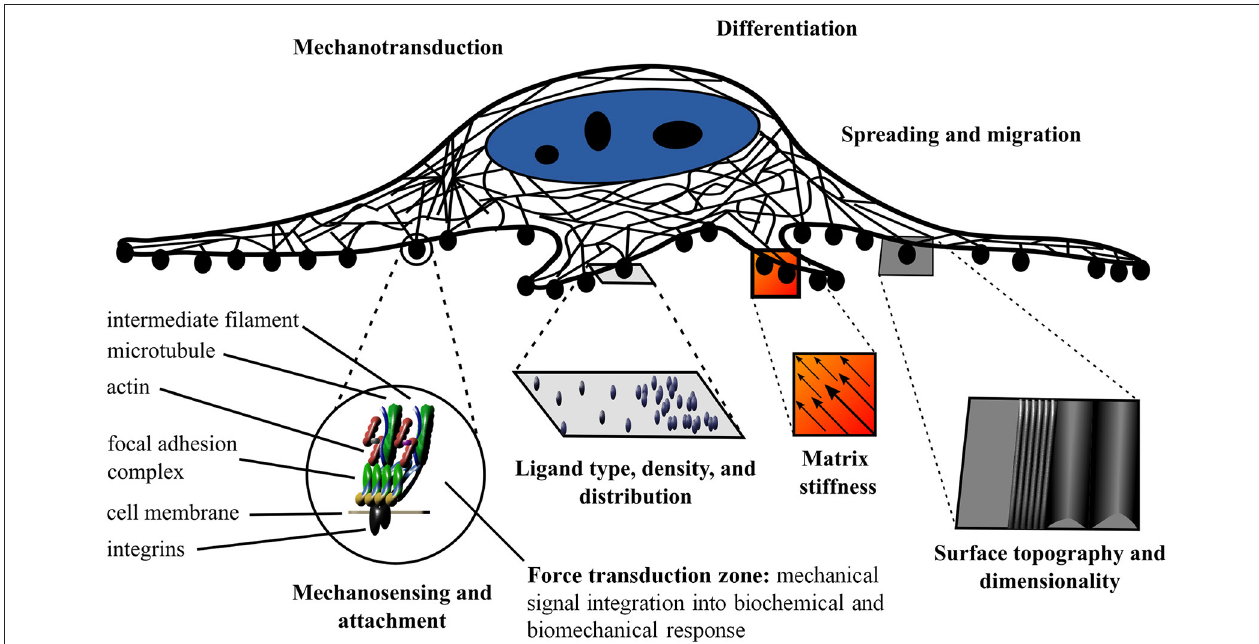
FIGURE 1 | Schematic of the influence of the local physical and biochemical environment on cell fate and function. Mechanosensing and mechanotransduction are mediated by cell adherence to the substrate via integrins and the interaction of focal adhesions and the cytoskeleton. The ligand type, density, and distribution as well as the matrix stiffness, surface topography, and dimensionality provide distinct cues to the cell and elicit specific